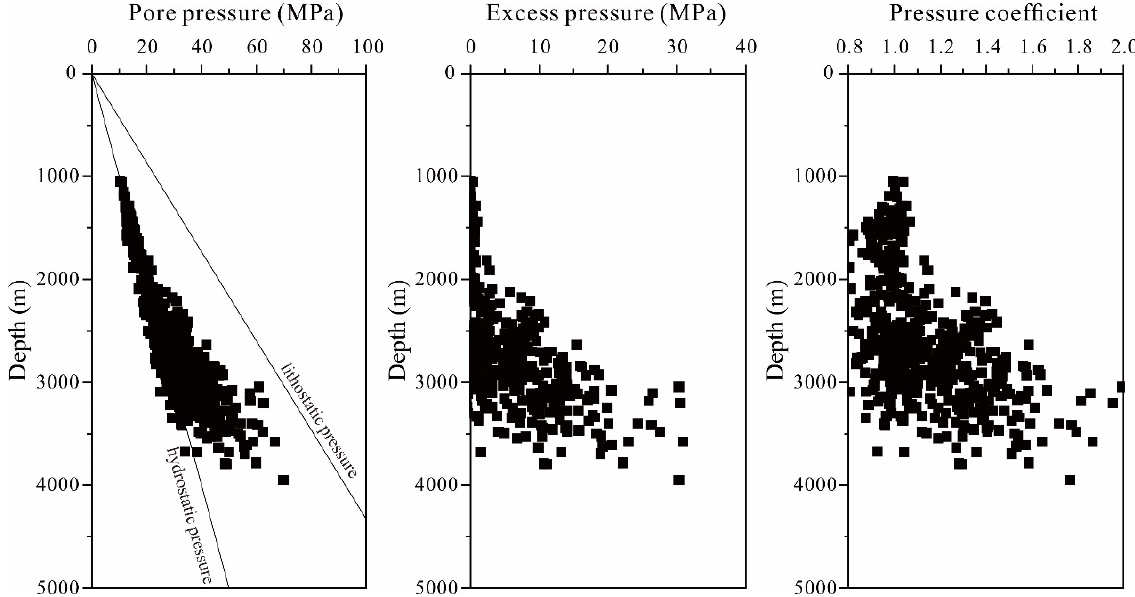
Figure 6. Profiles of DST pressure data, excess pressures, and pressure coefficients versus depth in the upper interval of Es4 member of Dongying Depression.